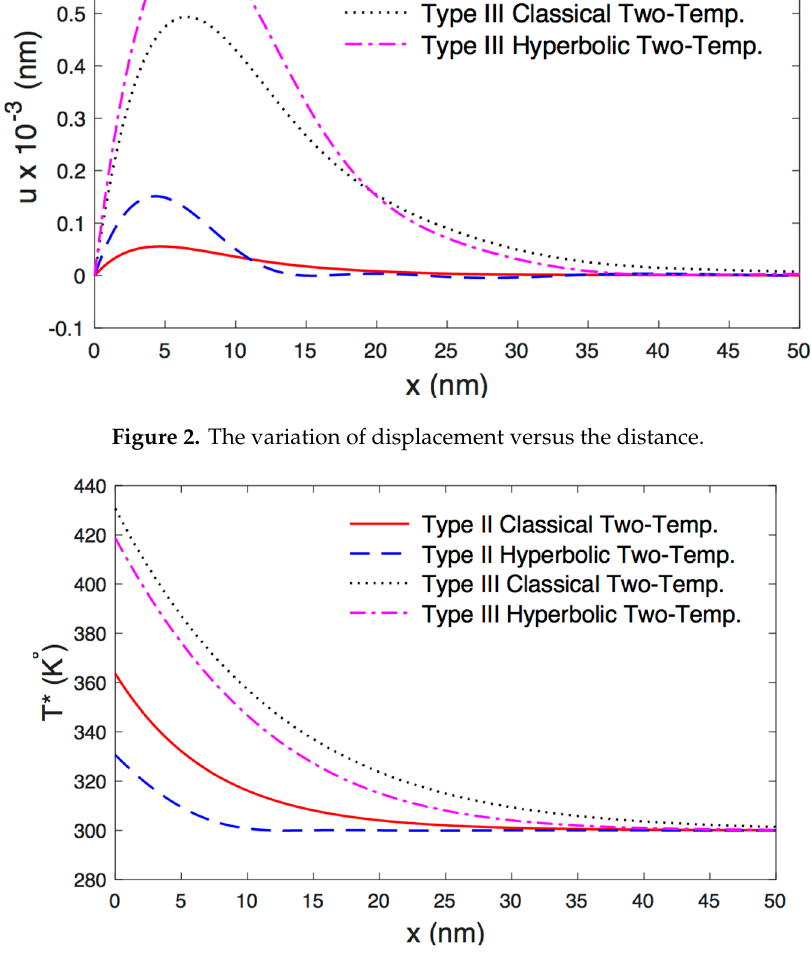
Figure 3. The variation of thermodynamic temperature with respect to the distance.